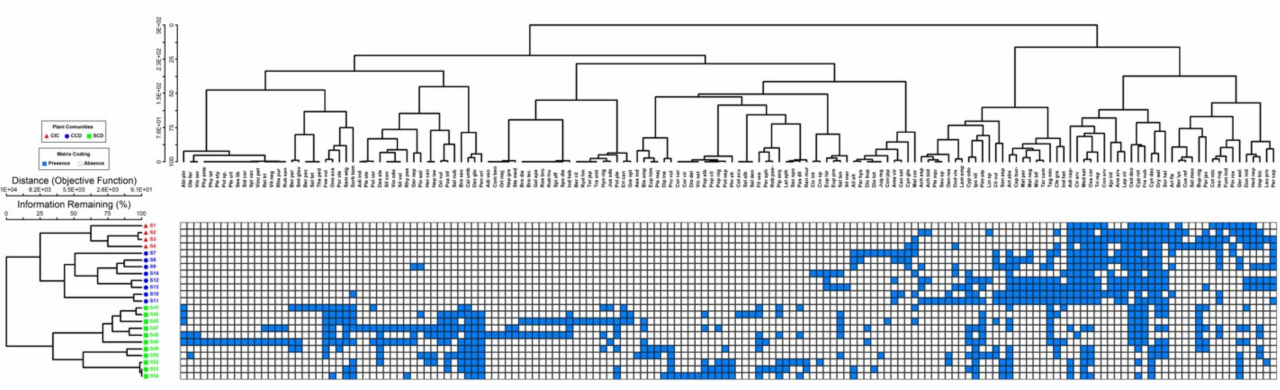
Figure 3. TWCA analysis displaying three distinct communities recognized based on 162 plant species recorded from 23 stands. Each blue dot represents the existence of a species, whereas each white dot indicates its absence. (For the complete names of plant communities, see Figure